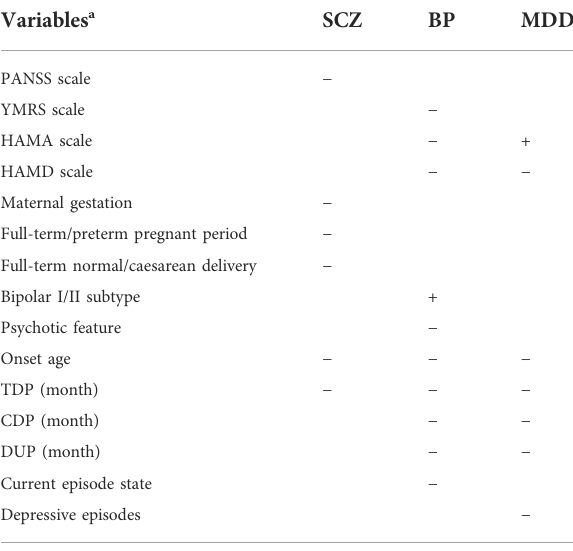
TABLE 4 Comparison of clinical features of SCZ, BP and MDD patients between the lipid-based subgroups. Variables